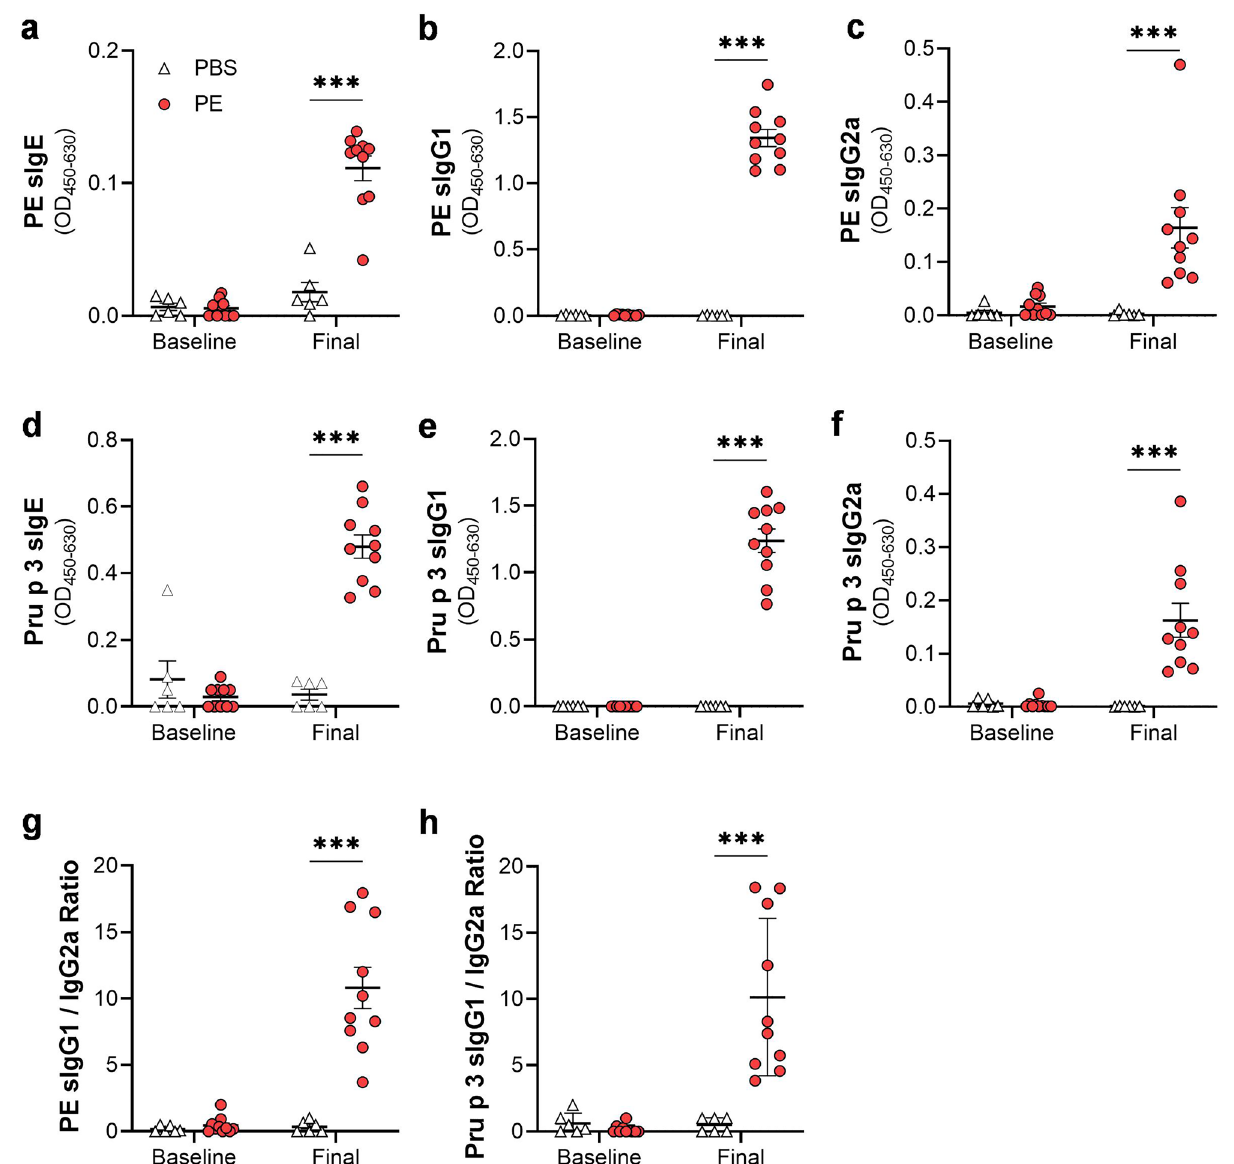
Figure 3. Peach extract- and Pru p 3-specific antibody response in the serum. Levels of Peach extract (PE)- specific ( a ) IgE, ( b ) IgG1 and ( c ) IgG2a, as well as Pru p 3-specific ( d ) IgE, ( e ) IgG1 and ( f ) IgG2a were analyzed in the serum of the mice before (baseline) or after (final) sensitization and provocation via ELISA. Ratio of ( g ) PE-specific and ( h ) Pru p 3-specific IgG1 to IgG2a were determined for baseline and final timepoint. n = 6–10, data presented as combination of 2 experiments performed under identical settings; *** p <